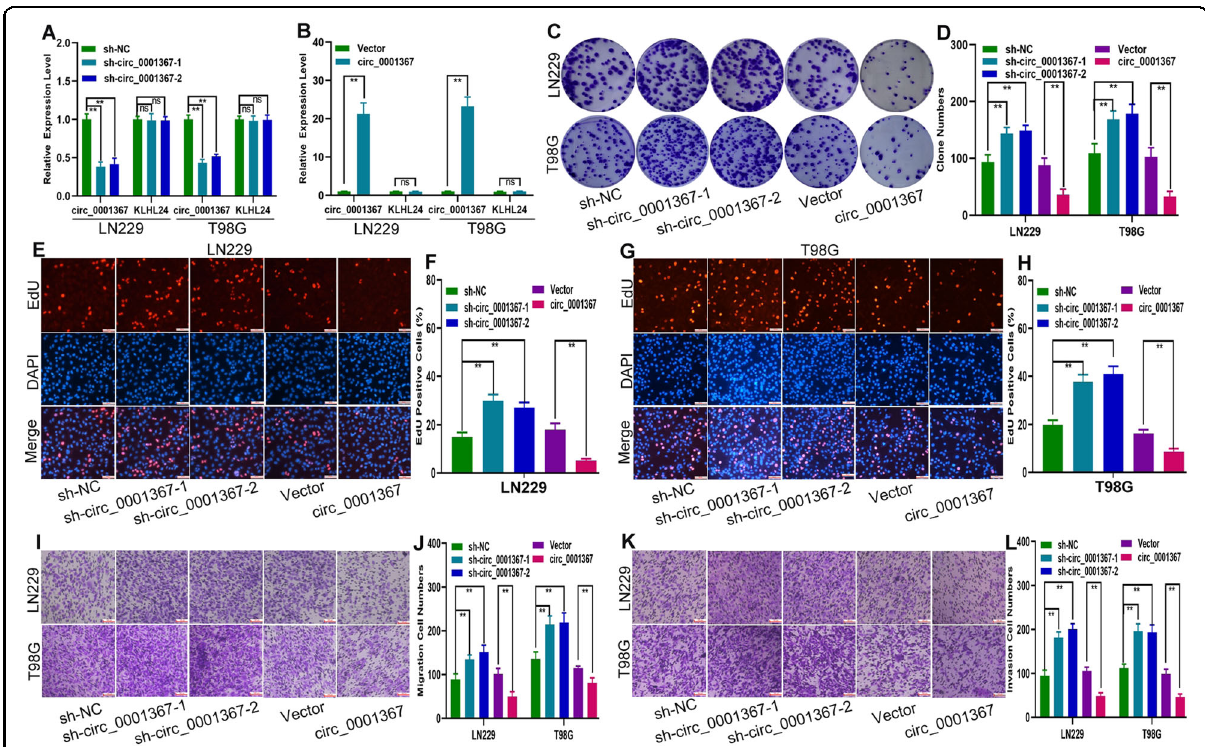
Fig. 2 Circ_0001367 inhibited the proliferation, migration and invasion abilities of glioma cells in vitro. A , B qRT-PCR analysis of circ_0001367 expression in LN229 and T98G cells after transfection of the expression vector or shRNA. C , D Clone formation assays showed the clone formation ability of LN229 and T98G cells transfected with the expression vector or shRNA. E – H Cell proliferation analysis by EdU assay after LN229 and T98G cells were transfected with the expression vector or shRNA. I , J Cell migration analysis with a Transwell assay after glioma cells were transfected with the expression vector or shRNA. K , L Cell invasion was evaluated via Transwell assay after glioma cells were transfected with the expression vector or shRNA. Each experiment was performed in triplicate. Data are expressed as mean ± SD, ** P <